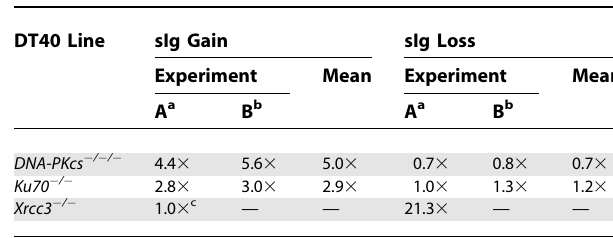
Table 1. Estimated Changes in sIg Reversion Rates Relative to